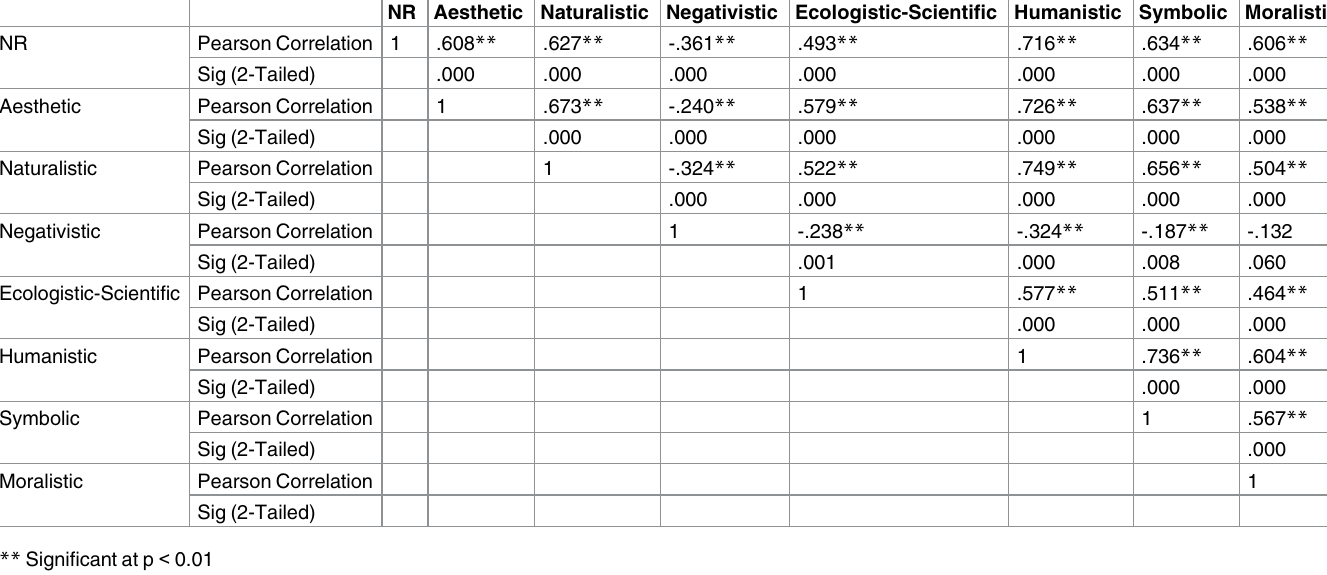
Table 4. Inter-Correlations between valuing being able to engage with the nine values of biophilia (N = 203). NR Aesthetic Naturalistic Negativistic Ecologistic-Scientific Humanistic Symbolic Moralistic